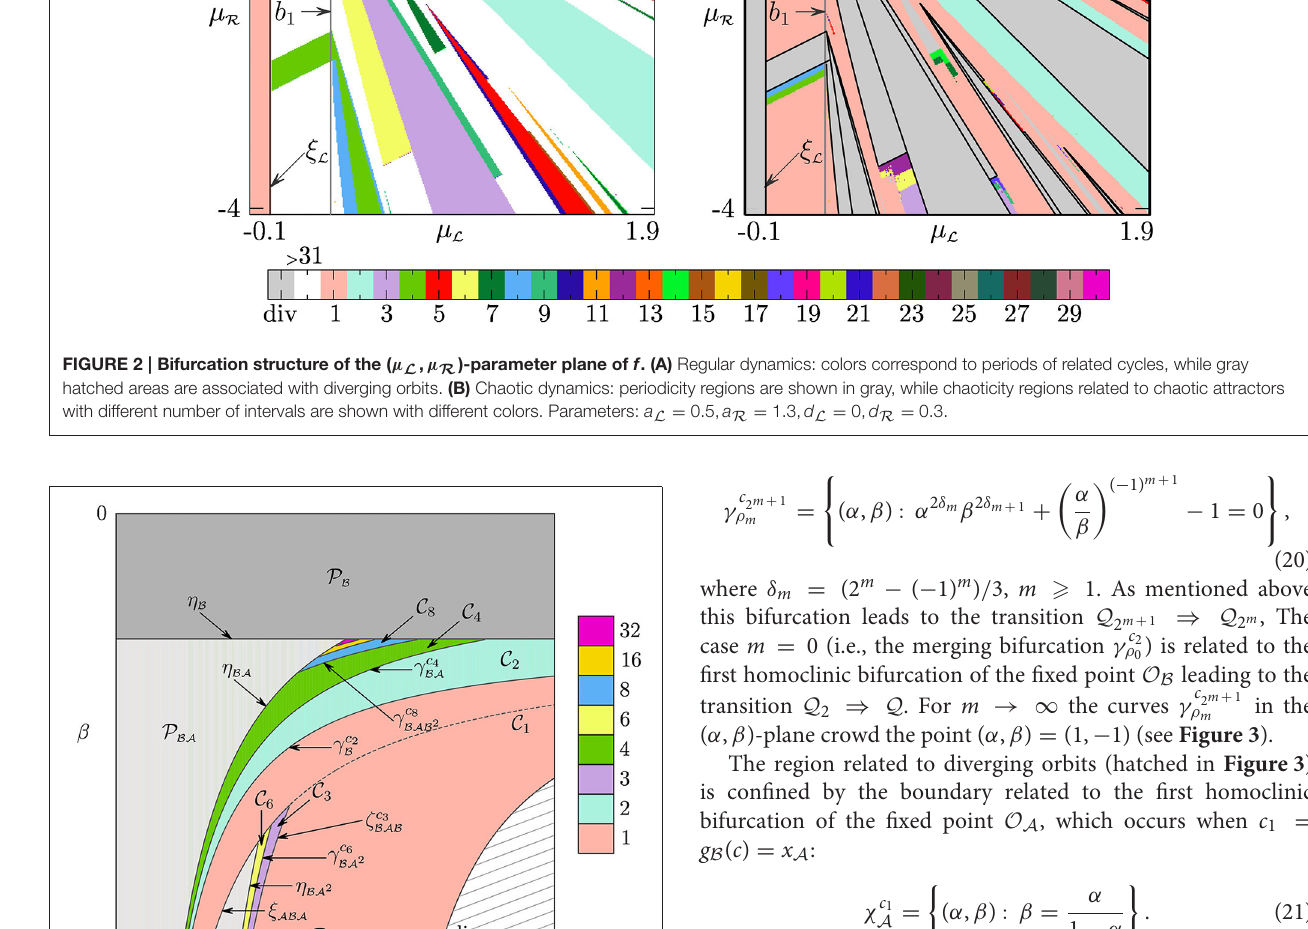
(14) for the first homoclinic bifurcation of O BA n − 1 the symbolic sequence BA n − 1 BA n − 2 B is the first harmonic of BA n − 1